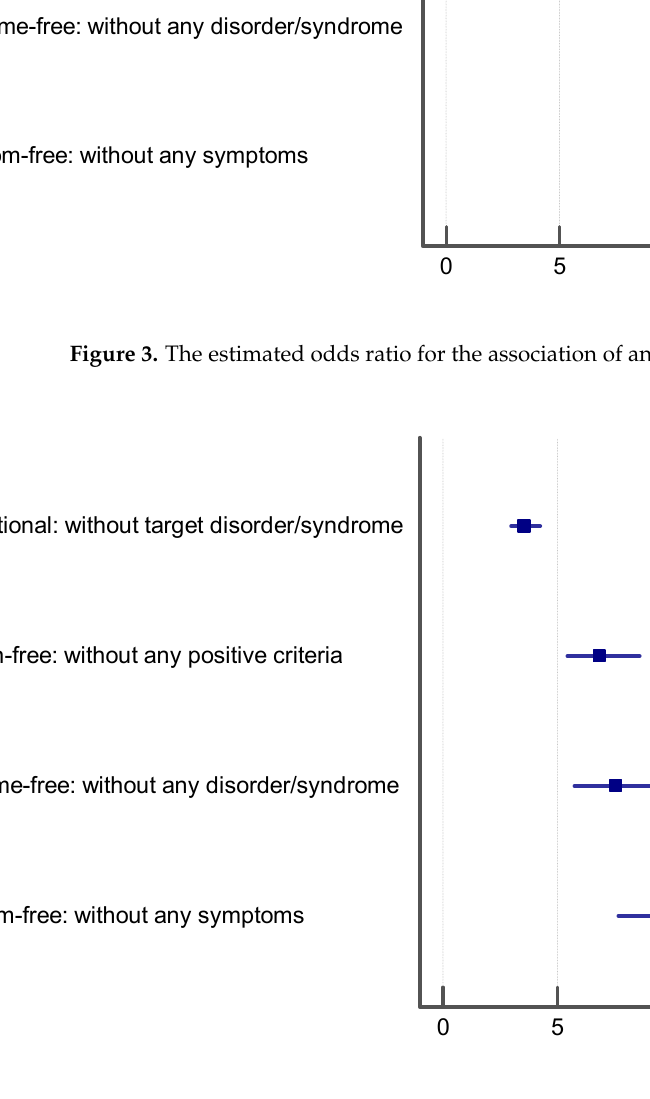
Figure 4. The estimated odds ratio for the association of depression and FD in each control group.